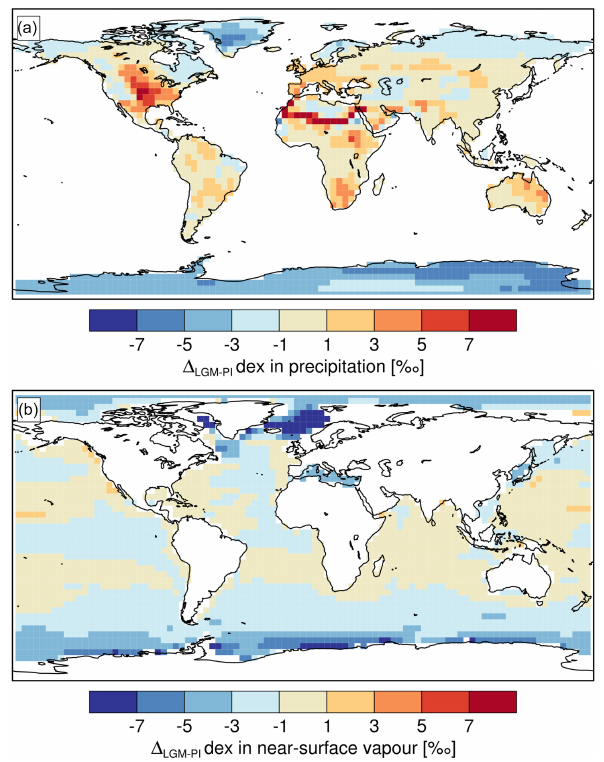
Figure 12. Global distribution of simulated annual mean LGM-PI deuterium excess (dex) changes in (a) continental precipitation and (b) water vapour of the lowest atmospheric model layer above the ocean